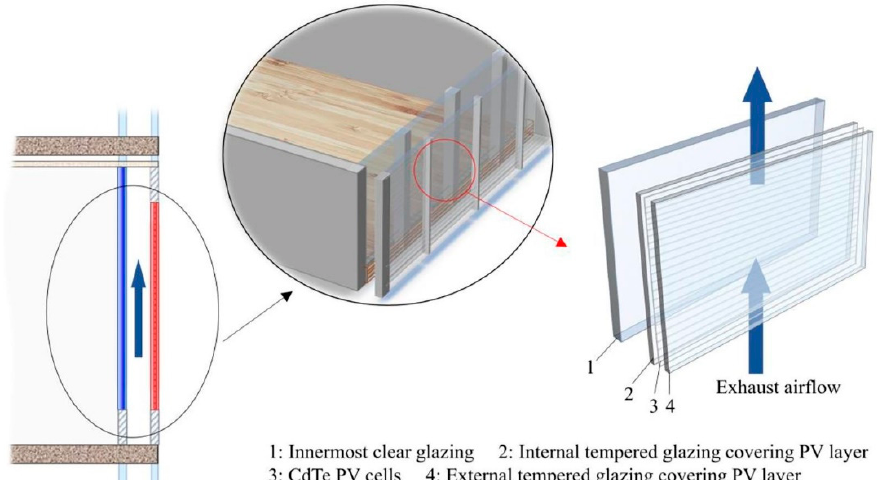
Figure 22. Proposed PV-incorporated DGU system by Tang et al. [64].